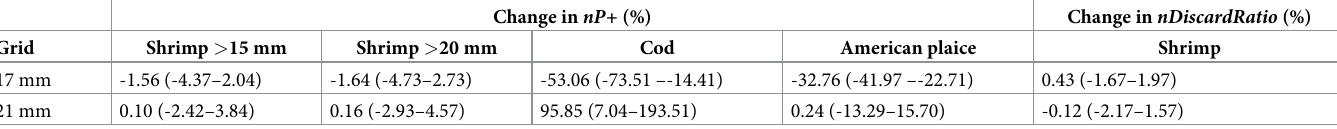
Table 6. Change in the catch efficiency indicator nP+ (in %) for Northern shrimp with carapace lengths > 15 mm and > 20 mm, respectively and bycatch species (cod and American plaice) and fraction of undersized shrimp ( nDiscardRatio ) (in %) when using the 17 and 21 mm bar spacing with respect to the 19 mm bar spac- ing (baseline) for the population encountered.